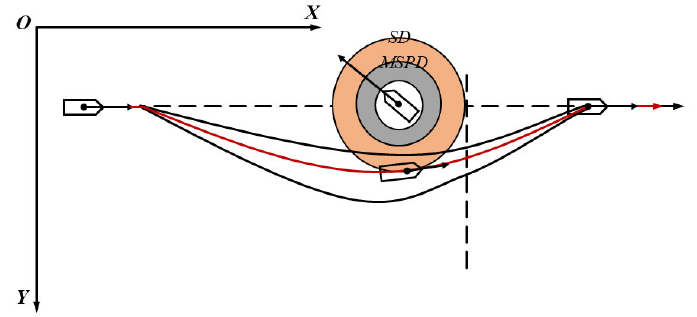
Figure 4. Illustration of the collision avoidance process of a ship at the remote-control level.